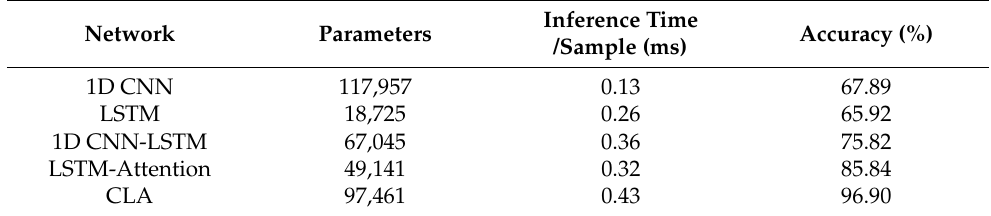
( j ) Figure 14. The MDM and feature heatmap of the attention mechanism for the different activities: ( a ) grayscale MDM of label 0; ( b ) grayscale MDM of label 1; ( c ) grayscale MDM of label 2; ( d ) grayscale MDM of label 3; ( e ) grayscale MDM of label 4; ( f ) heatmap of label 0; ( g ) heatmap of label 1; ( h ) heatmap of label 2; ( i ) heatmap of label 3; ( j ) heatmap of label 4. 4.6. Comparison of Different Literature Networks In this section, multiple networks from the literature are employed for performance comparison. The parameters, inference time, and floating point operations (FLOPs),